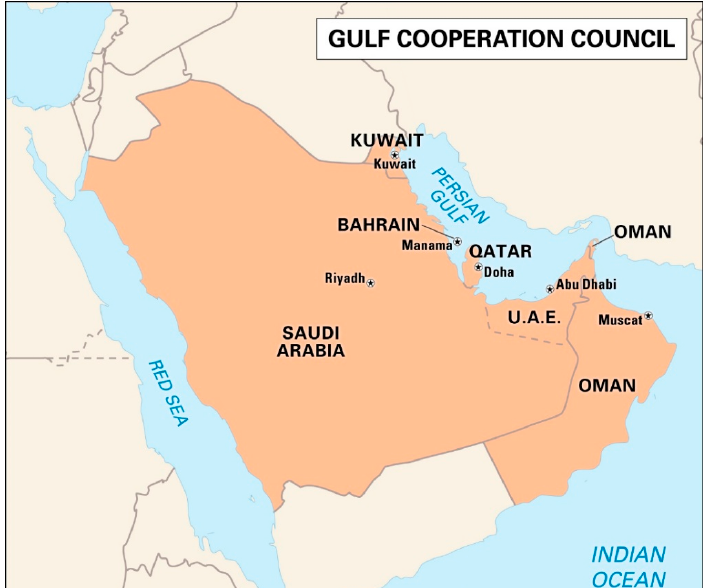
Figure 1. Map of the Gulf Cooperation Council (GCC) countries.